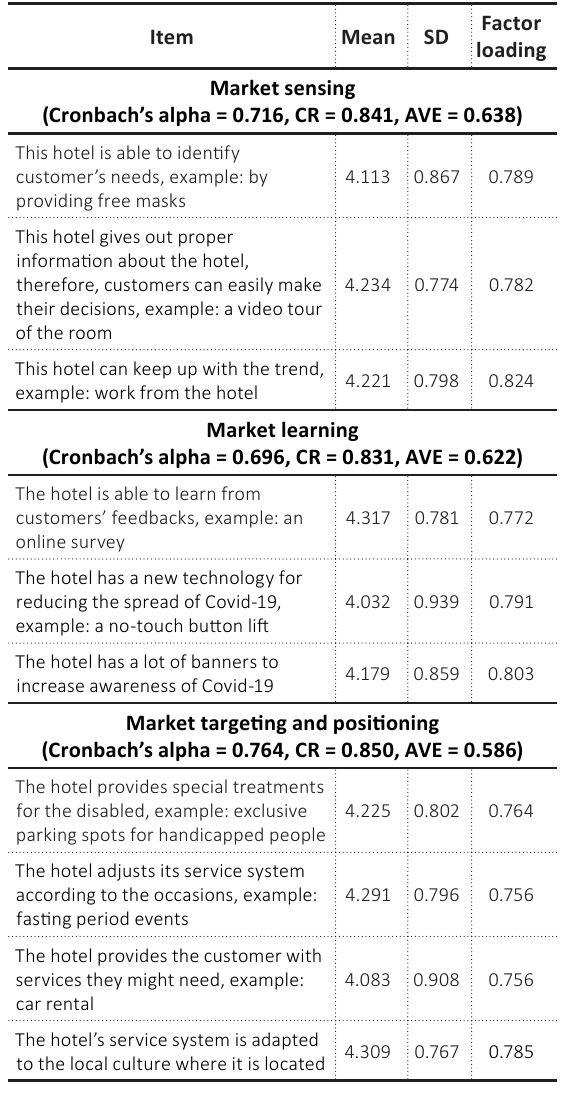
Table 2. Measurement